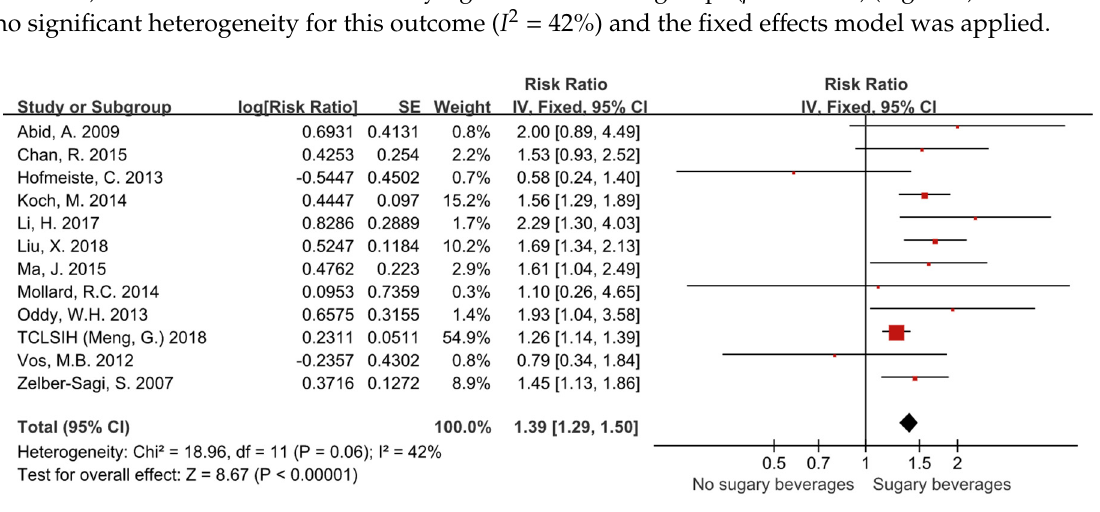
Figure 2. Forest plots showing that the consumptions of sugar-sweetened beverages increased the relative risk of NAFLD by